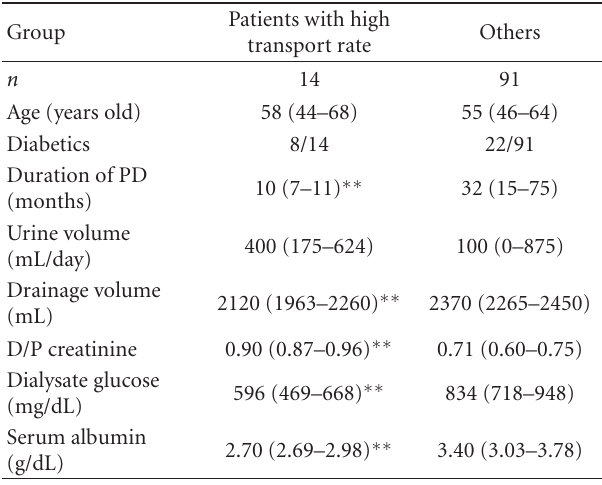
Table 1: Clinical characteristics and the results of the fast peritoneal equilibration